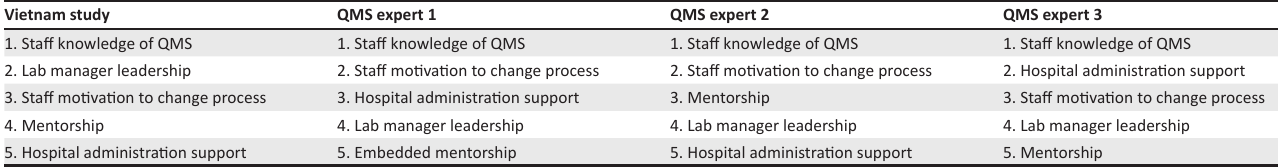
TABLE 3: Comparative ranking of critical success factors between the Vietnam study and expert panel. Vietnam